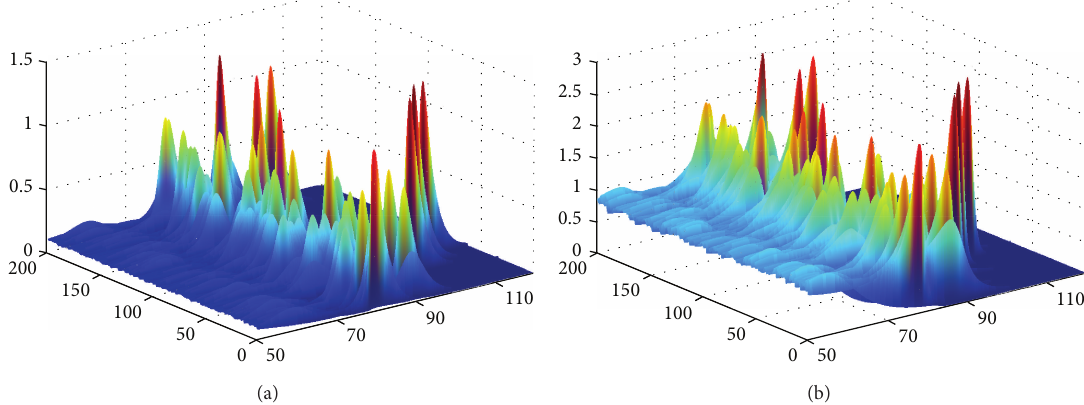
Figure 2: Solution to (𝑝(𝑥,𝑡),𝑧(𝑥,𝑡)) for (4). Phytoplankton is in (a) and zooplankton is in (b). The parameter values are the same as those given in Figure